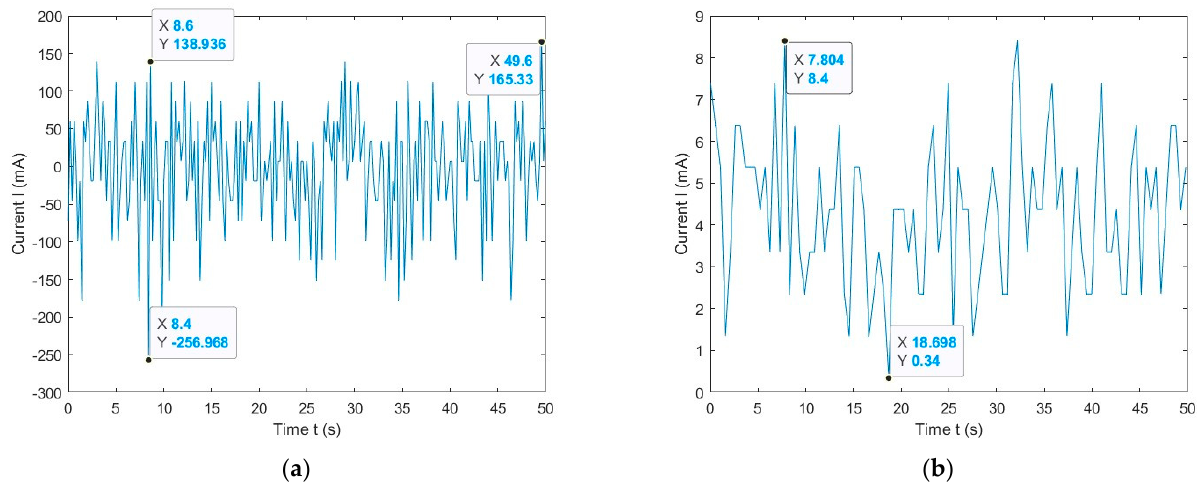
Figure 20. Variation in the current provided by the ACS712-05 sensor without current consumption: ( a ) for a 10-bit ADC and ( b ) for a 16-bit ADC.